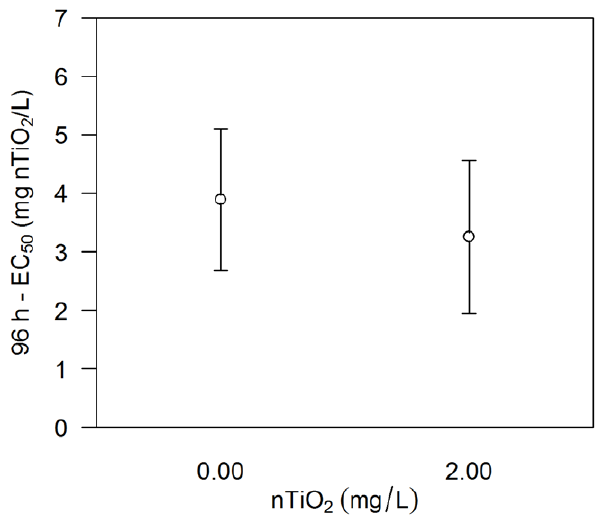
Figure 5. The sensitivity of juveniles released during the third set of experiments. 96 h- EC 50 values with respective 95% CIs of the fifth brood released by adults exposed to 0.00 and 2.00 mg/L P25-nTiO 2 during the third set of experiments, which considered exclusively potential implication of nTiO 2 exposure within the brood pouch. No statistically significant difference among treatments was observed.